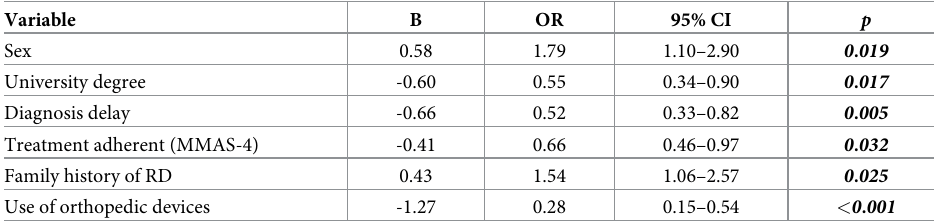
Table 7. Predictive factors by multivariate logistic regression of CAM use for patients with RD (n = 500). Variable B OR 95% CI p